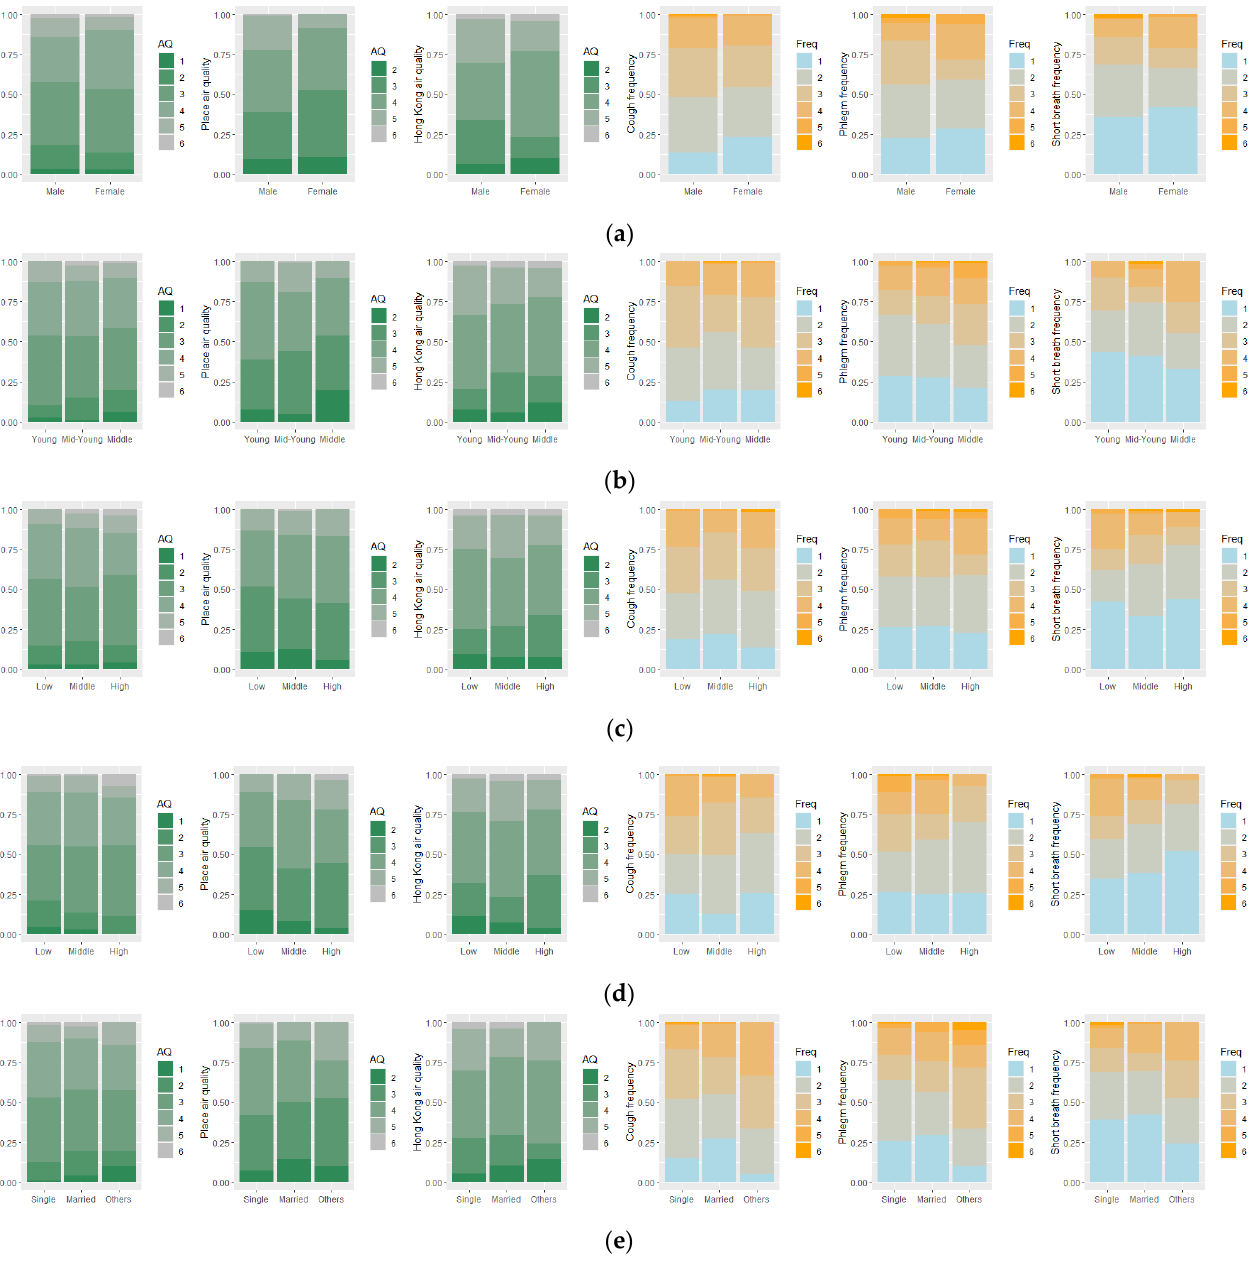
Figure 3. Distribution of participants’ perceived air quality and their self-reported respiratory symp- toms in different geographic contexts. AQ is short for air quality. Table 2. Mann–Whitney U tests of difference in participants’ perceived air quality regarding differ- ent socio-demographic axes and geographic contexts. Axis